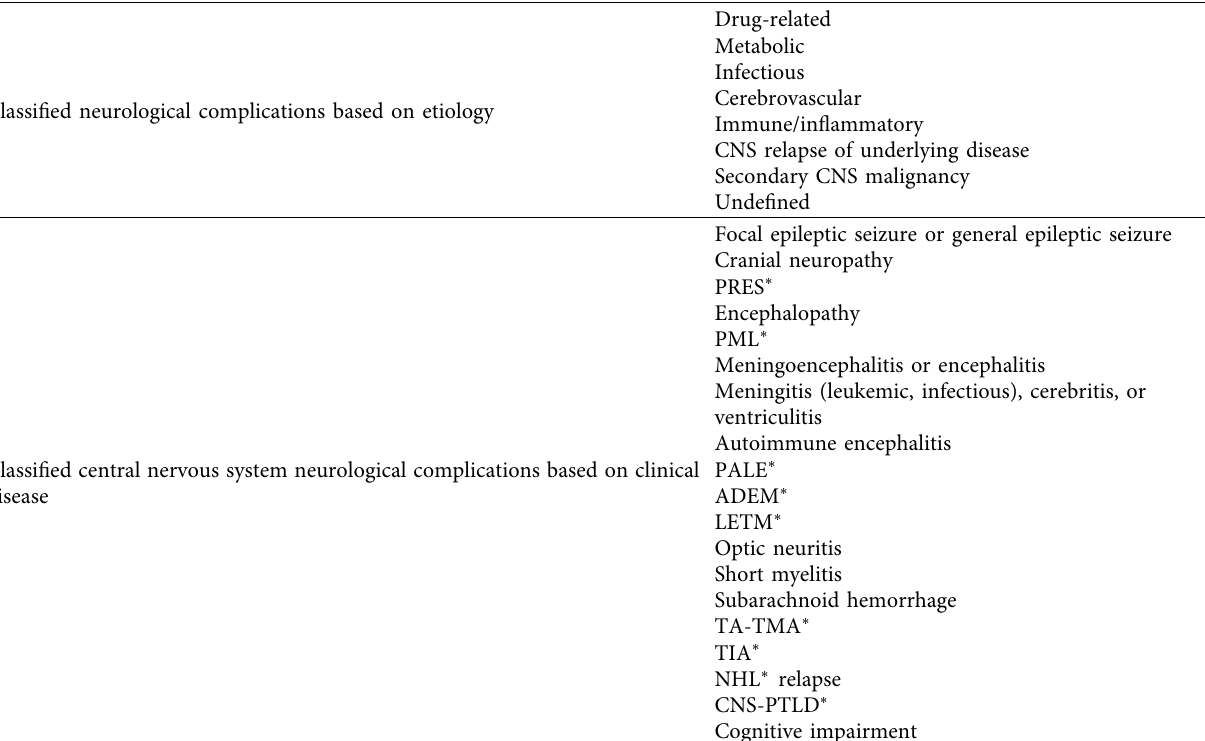
Classified neurological complications based on etiology